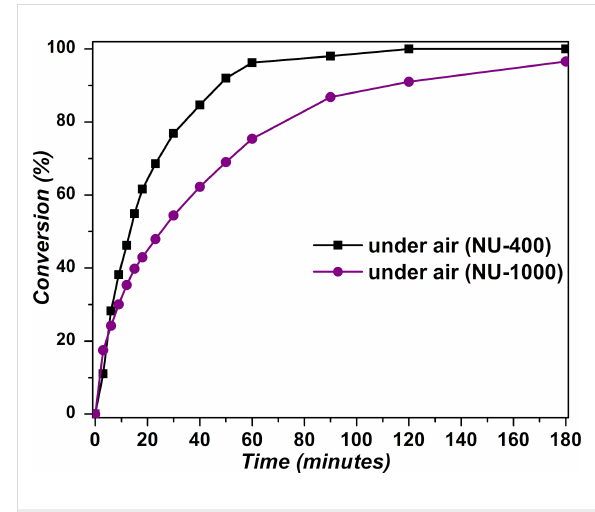
Figure 3: Selective oxidation of CEES to CEESO using 1 mol % cata- lyst of NU-400 (black) versus NU-1000